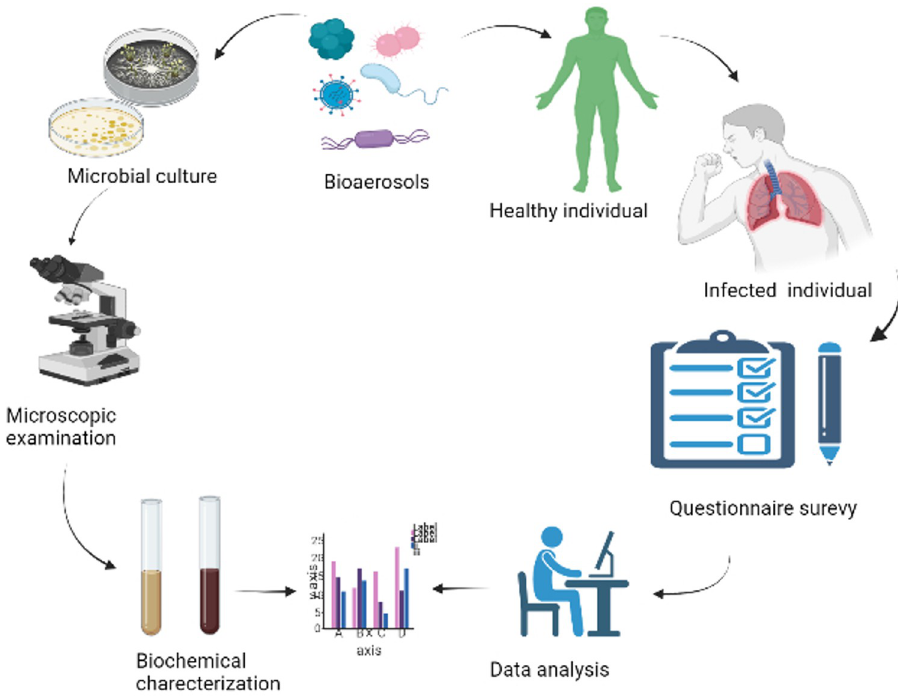
Fig 1. Overview of the research